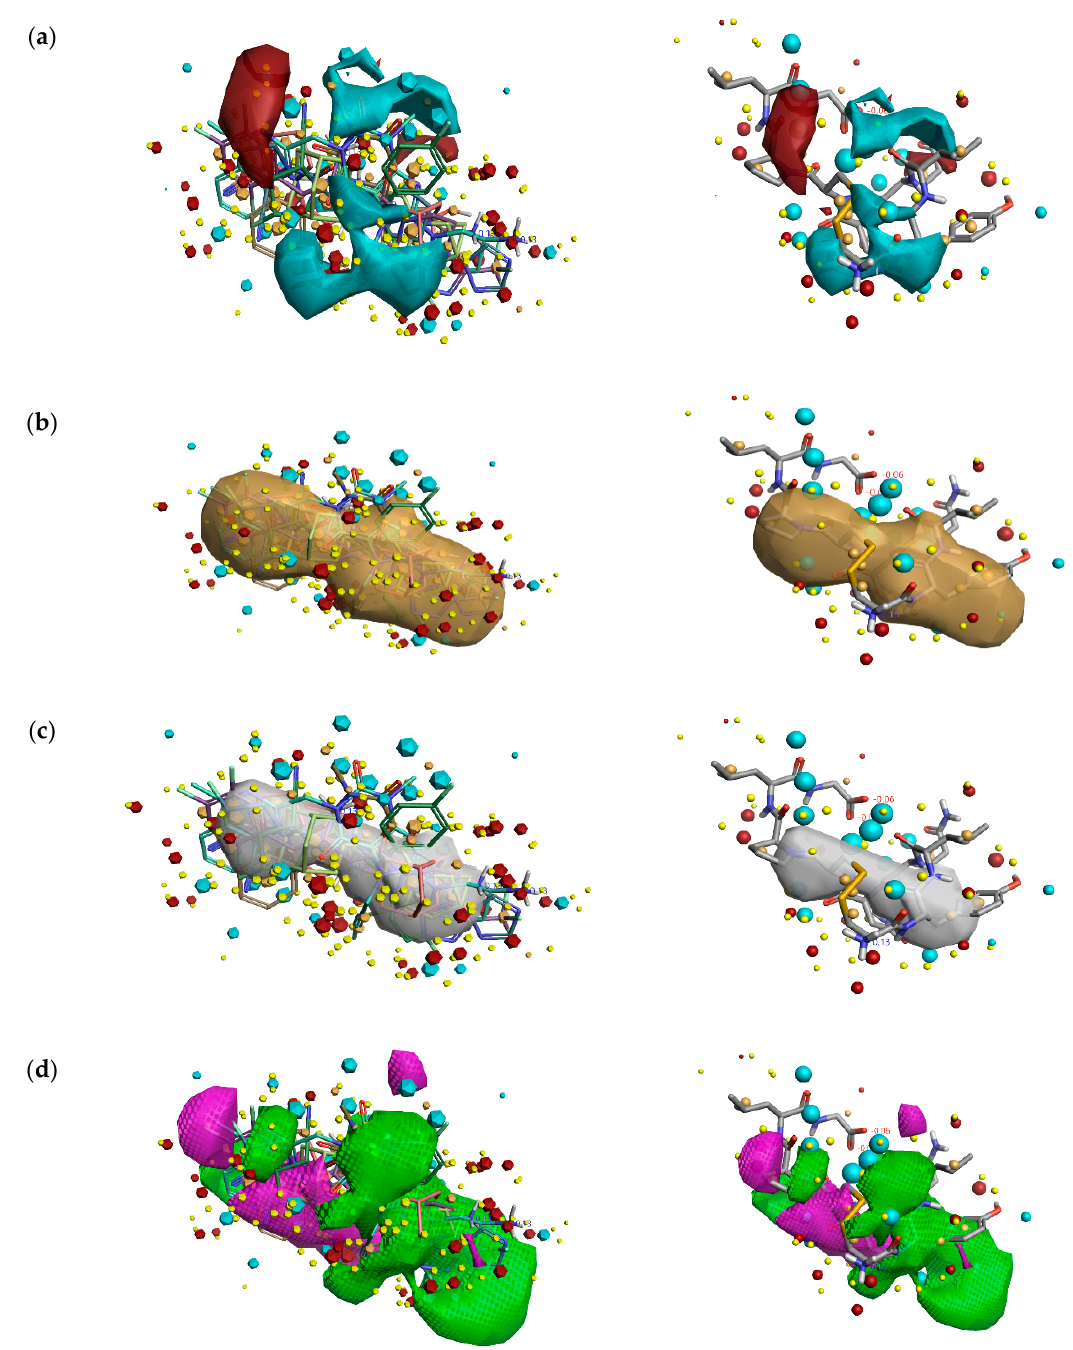
Figure 2. Activity atlas model describing the features responsible for DPP4 inhibition (left side) and features predicted for natural cyclic peptide oxytocin (right side). Forge tool was utilized to apply, analyze, and visualize features predicted by the activity atlas model. The generated model provides average electrostatics of positive actives in red color and negative electrostatics in blue color ( a ); an average of hydrophobicity ( b ); an average of actives ( c ); and activity cli ff summary of favorable and unfavorable shapes ( d